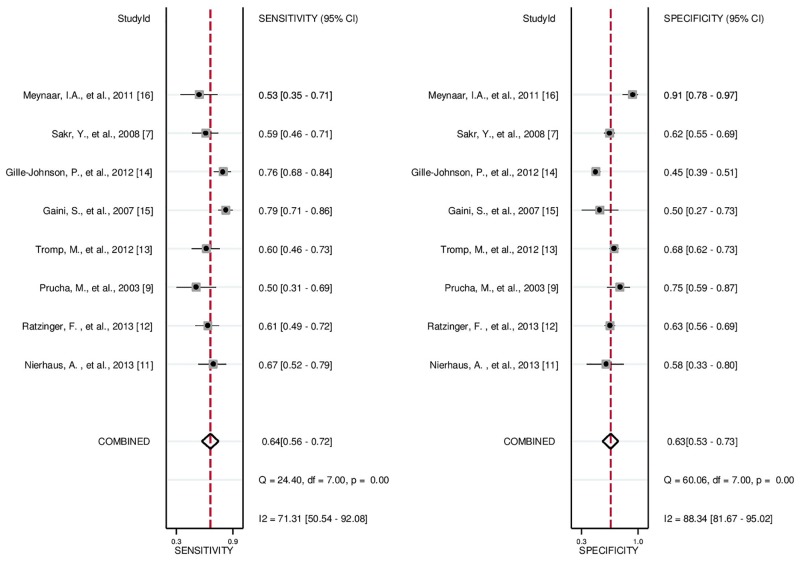
Forest plots of the sensitivity and specificity for serum LBP level across all included studies.